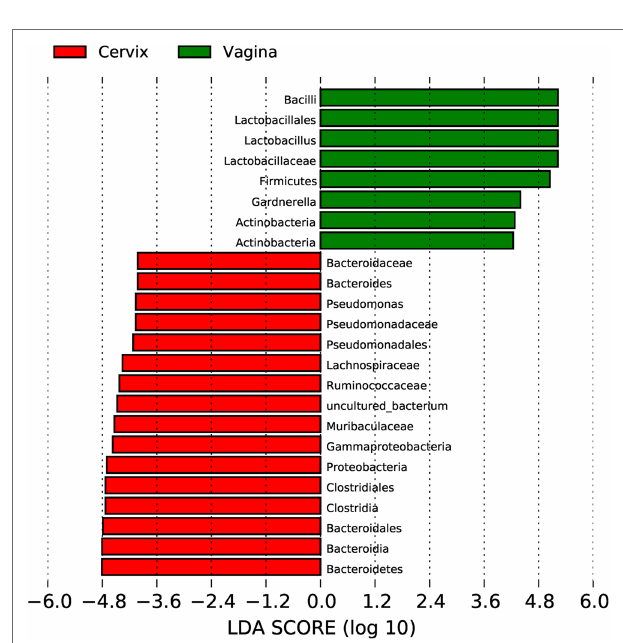
FIGURE 4 | Linear discriminant analysis to explore potential genera contributing to intergroup differentiation. The green bar indicates the genera contributing to the vaginal microbiota, while the red bars indicate the genera contributing to the cervical